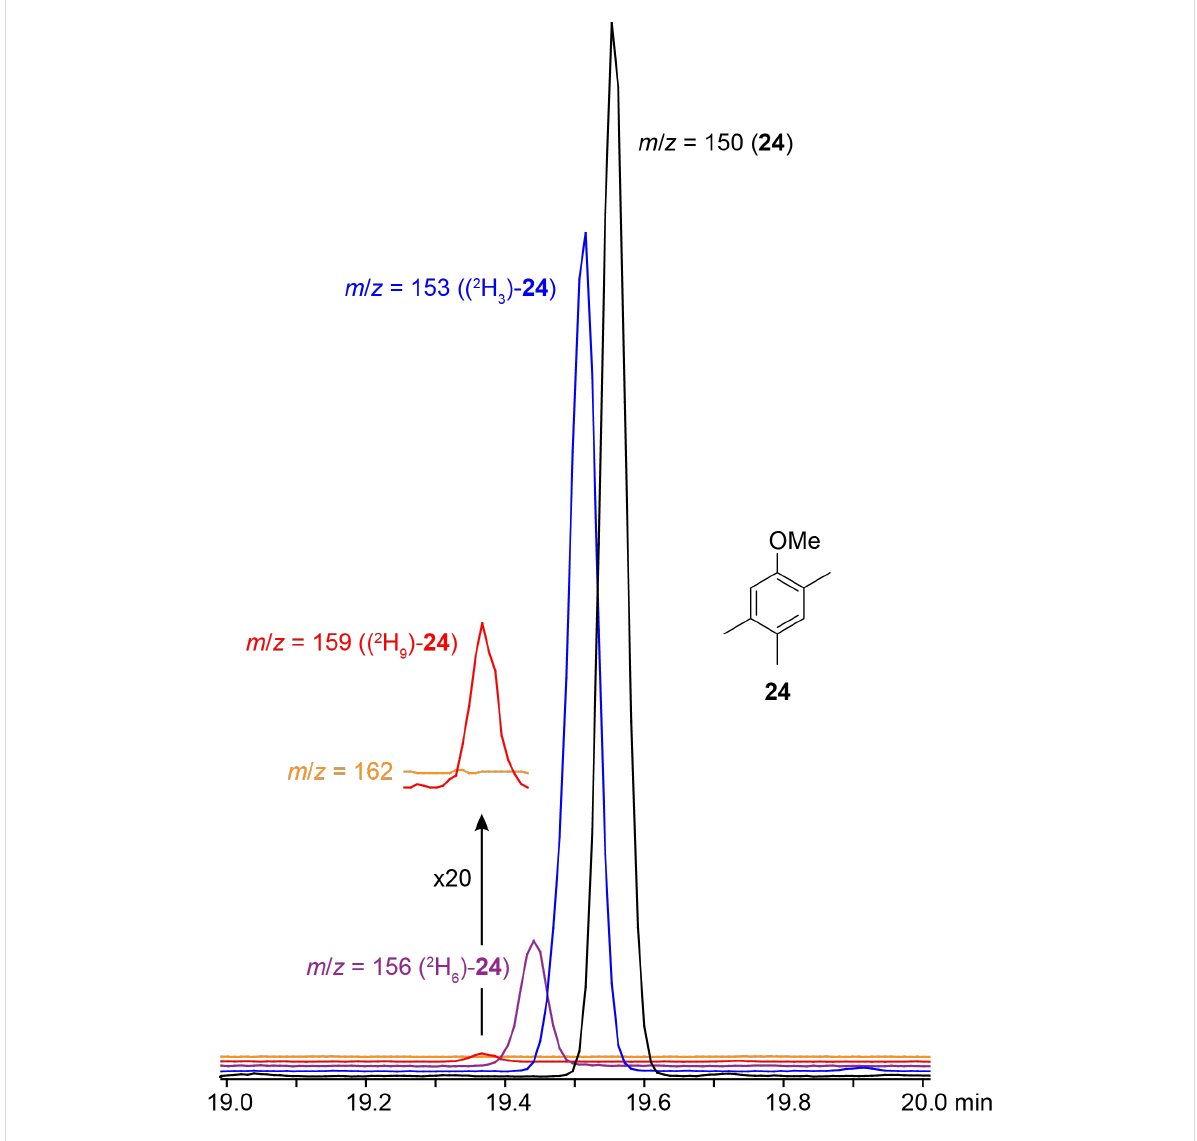
Figure 5: Biosynthesis of 24 . Feeding of ( methyl - 2 H 3 )methionine resulted in the incorporation of labelling into up to three methyl groups of 24 . The shown ion trace chromatograms represent unlabelled 24 (black, m / z = 150), ( 2 H 3 )- 24 (blue, m / z = 153), ( 2 H 6 )- 24 (purple, m / z = 156), and ( 2 H 9 )- 24 (red, m / z = 159). No incorporation into the fourth methyl group was observed (no peak visible for m / z = 162). For the ion trace chromatograms of m / z = 159 and 162 also expansions (20×) are